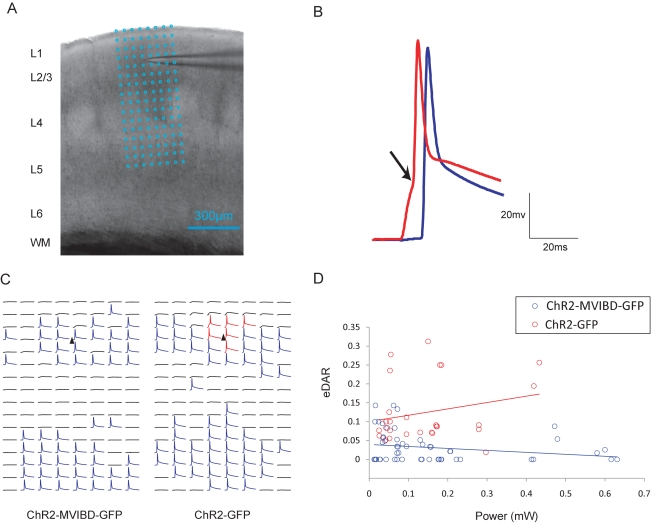
Interaction with Myosin VI promotes enrichment of ChR2 at the surface of axons of layer 2/3 pyramidal neurons.(A) Image of an acute brain slice with a recoding electrode. Cortical layers (L1 to L6) and white matter (WM) are indicated on the left. Blue grid represents 8×16 photostimulation patterns, with a spacing of 50 µm. (B) Schematic of waveforms triggered in soma and dendrites (red) and axons (blue). The arrow marks the clear inflection point (see Materials and Methods). (C) Example maps from a ChR2-MVIBD-GFP-positive cell (left) and a ChR2-GFP-positive cell (right). Black triangles mark soma locations. Blue traces indicate axonal excitation and red traces indicate somatic/dendritic excitation, respectively, using inflection point criteria. (D) The ratio of the number of APs evoked in soma and dendrites to the number of APs evoked in axons plotted against the laser power used for photostimulation. Blue circles represent the data points of the ChR2-MVIBD-GFP cells (n = 6), and red circles represent the data points of the ChR2-GFP cells (n = 8). The upward shift of the eDAR distribution of ChR2-MVIBD-GFP relative to that of ChR2-GFP is consistent with enrichment in axons of ChR2-MVIBD-GFP relative to ChR2-GFP.